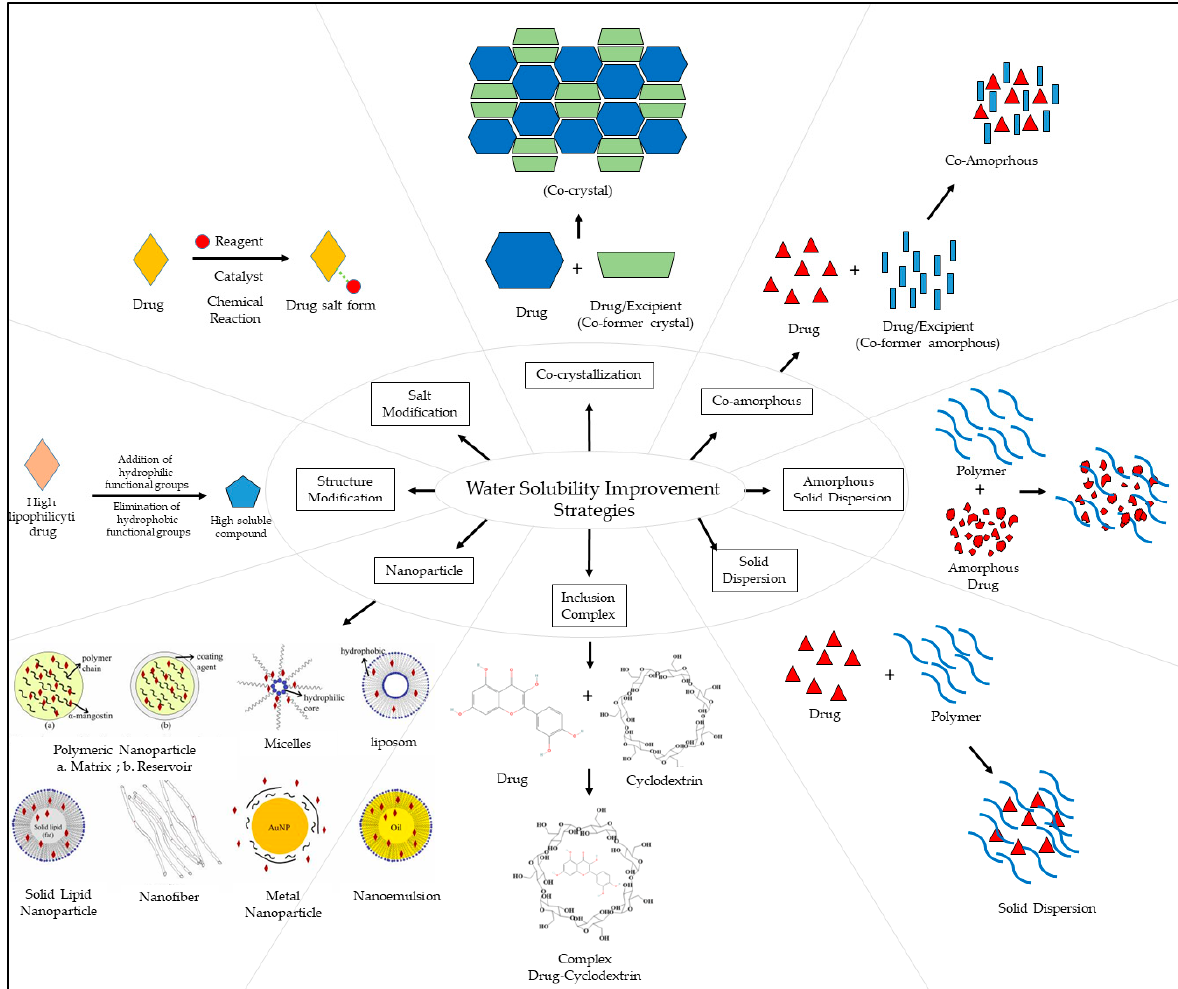
Figure 2. Water solubility improvement strategies overview.